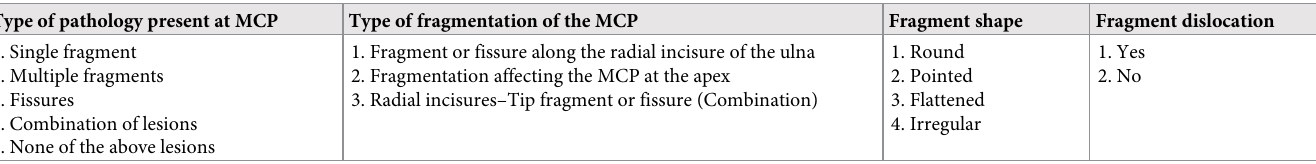
Table 2. Computed tomographic variables studied at the medial coronoid process [21, 40, 48]. Type of pathology present at